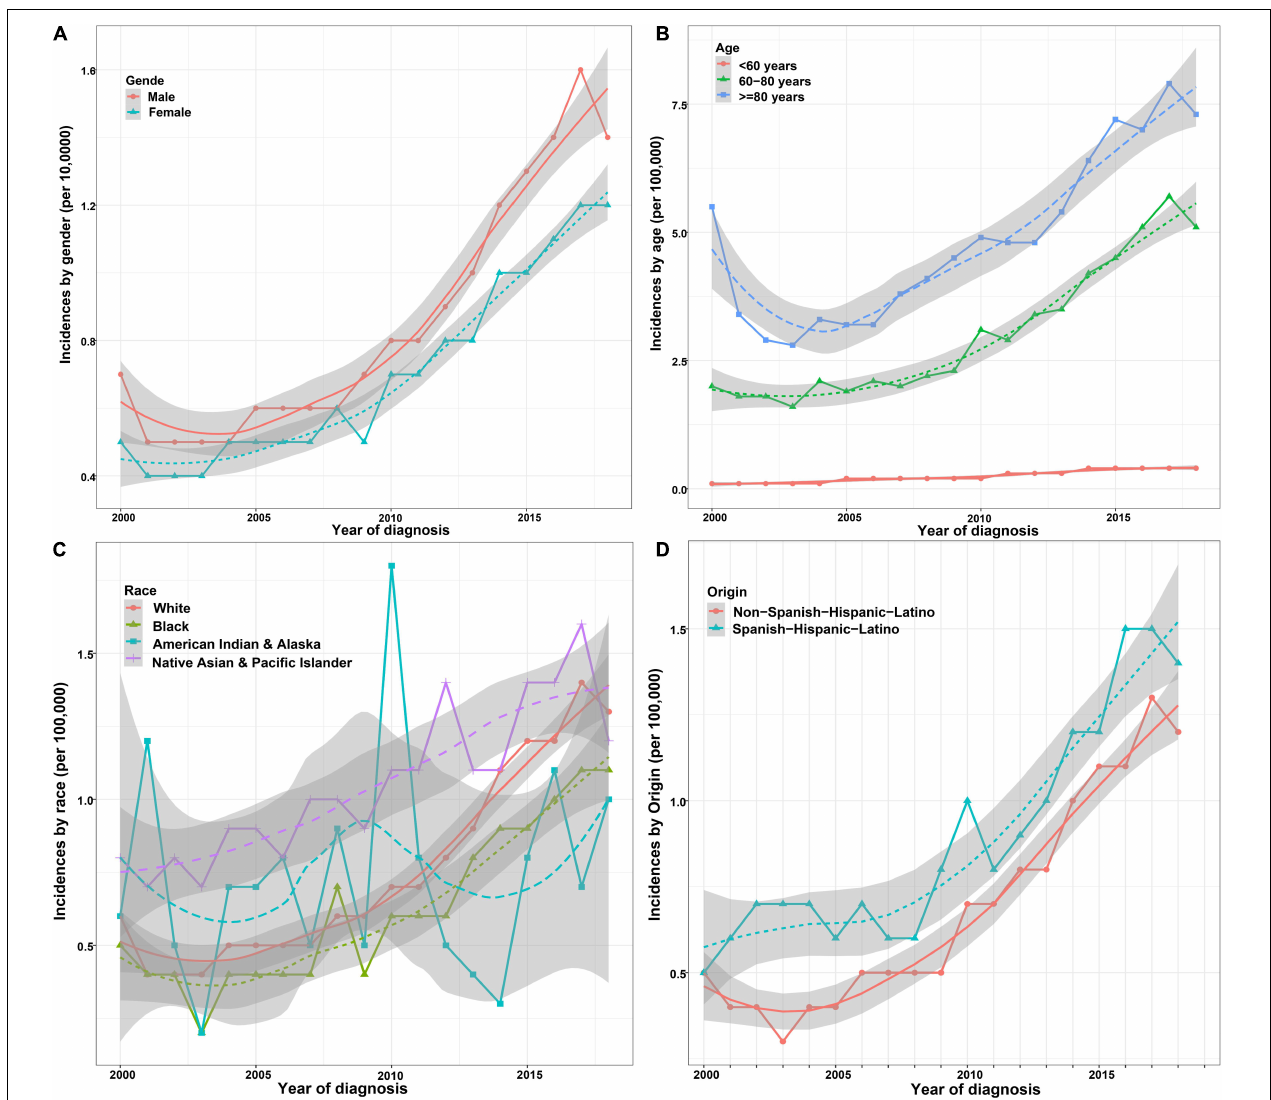
FIGURE 3 | Incidence trends of patients with ICCA in different demographic groups. (A) Incidence trends of patients with ICCA between different gender groups. (B) Incidence trends of patients with ICCA between different age groups. (C) Incidence trends of patients with ICCA between different race groups. (D) Incidence trends of patients with ICCA between different origin